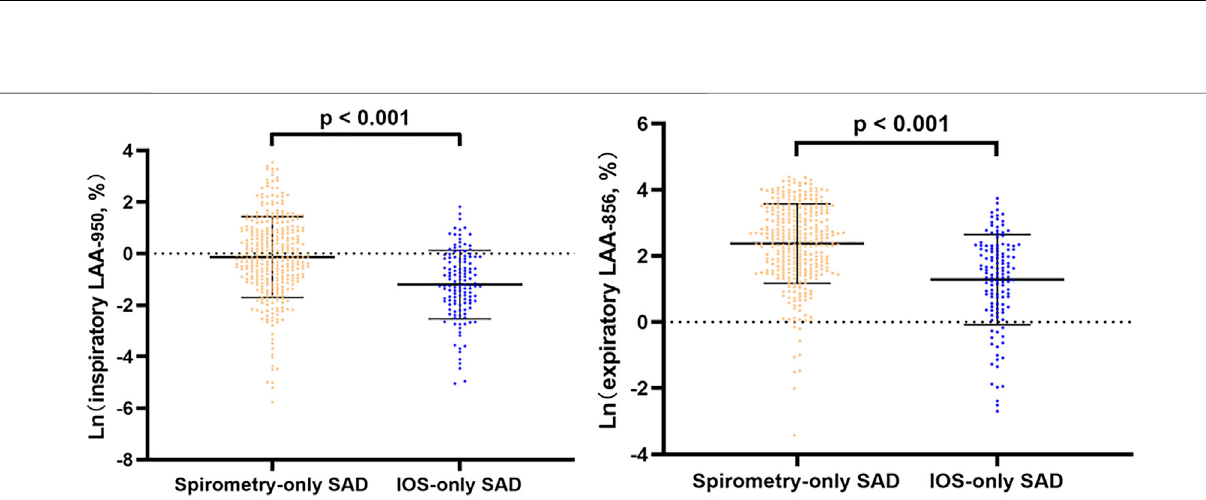
Frontiers in Physiology |